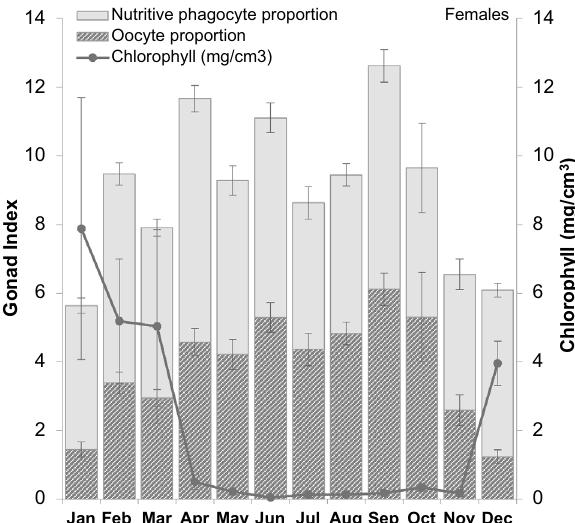
Figure 3. Monthly female gonad index as proportional area of nutritive phagocytes (NP) and oocytes. Monthly data for proportions are ± the standard error of the NP or oocyte equivalent GI based on replicate months. Chlorophyll data are represented on the secondary y-axis and have been averaged from the time series (2012– 2018), ± standard